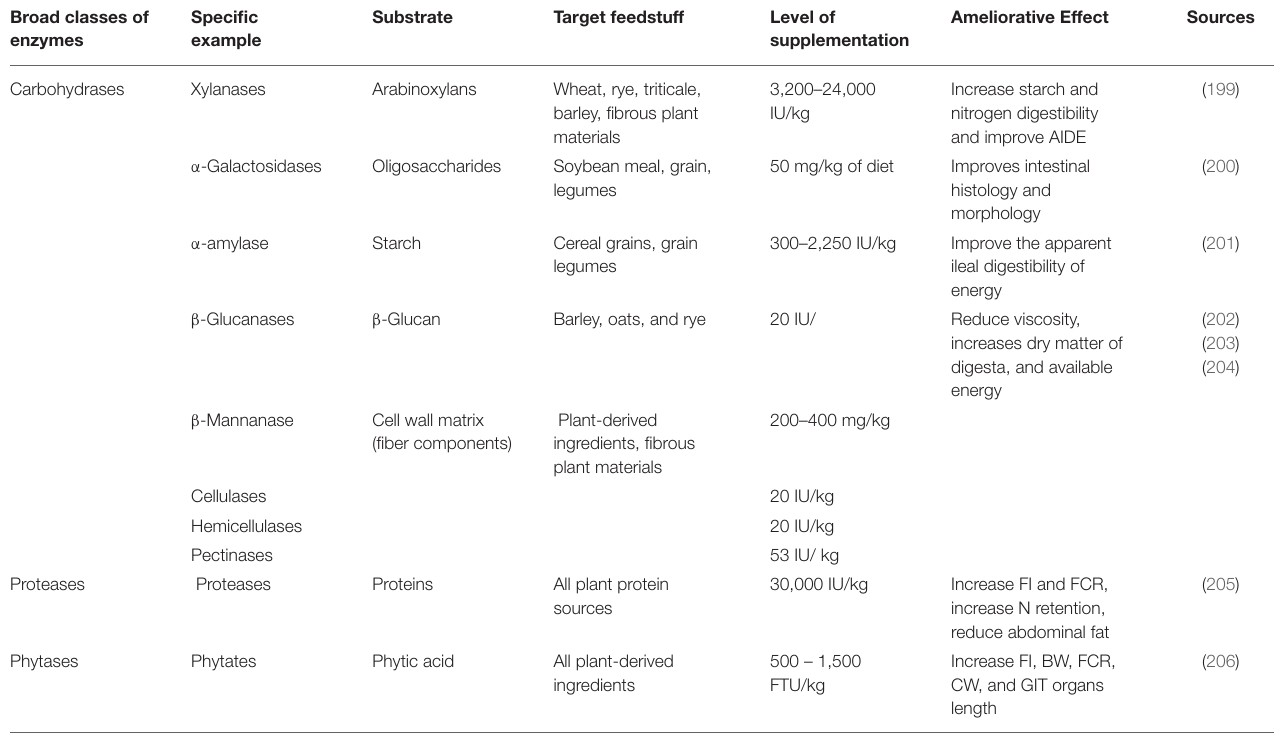
TABLE 5 | Enzymes, target substrates, and their benefits in broiler production. Broad classes of